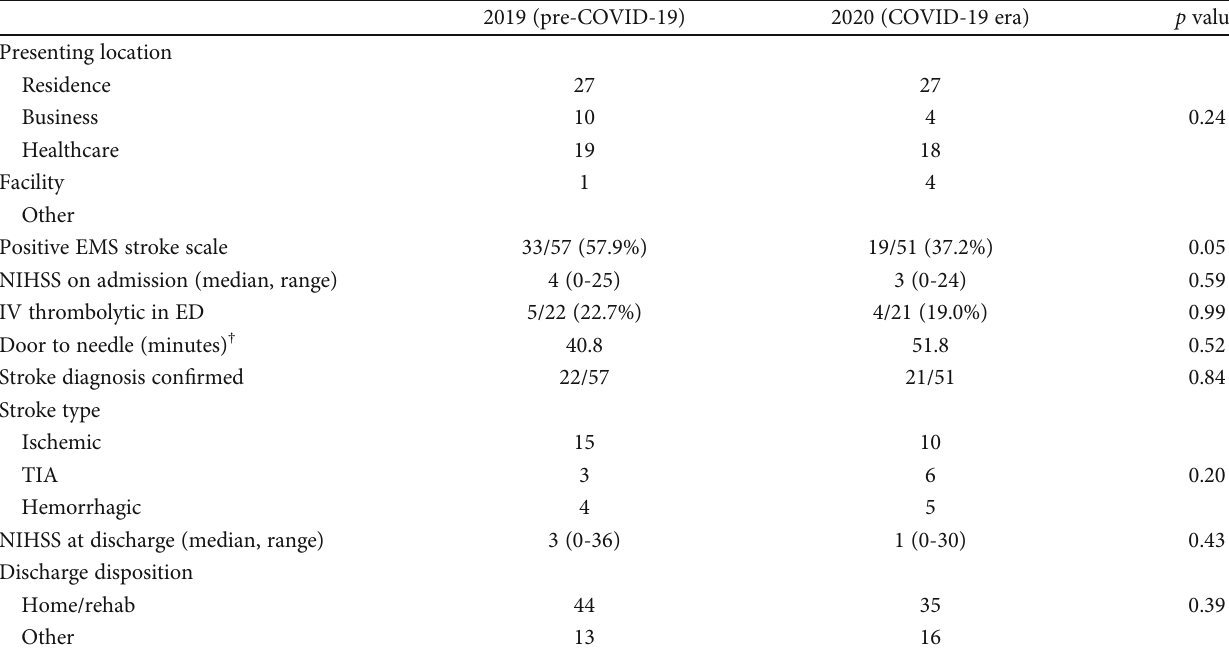
Table 3: Stroke evaluation, management, and